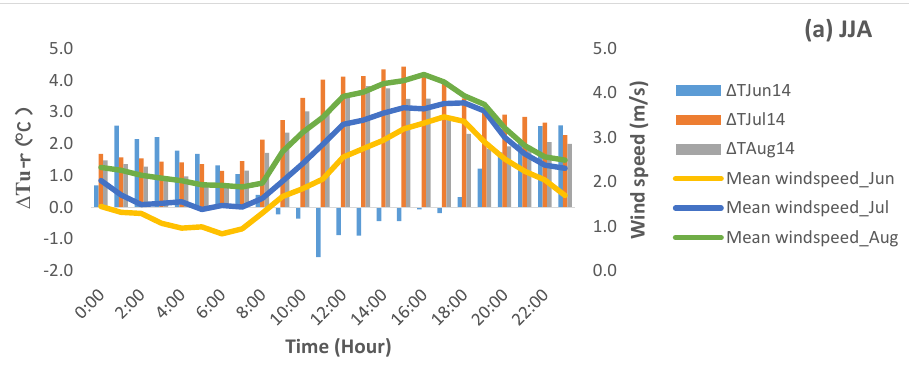
Figure 8. The effect of solar radiation on UHI pattern in ( a ) JJA; ( b ) SON; ( c ) DJF and ( d ) MAM.